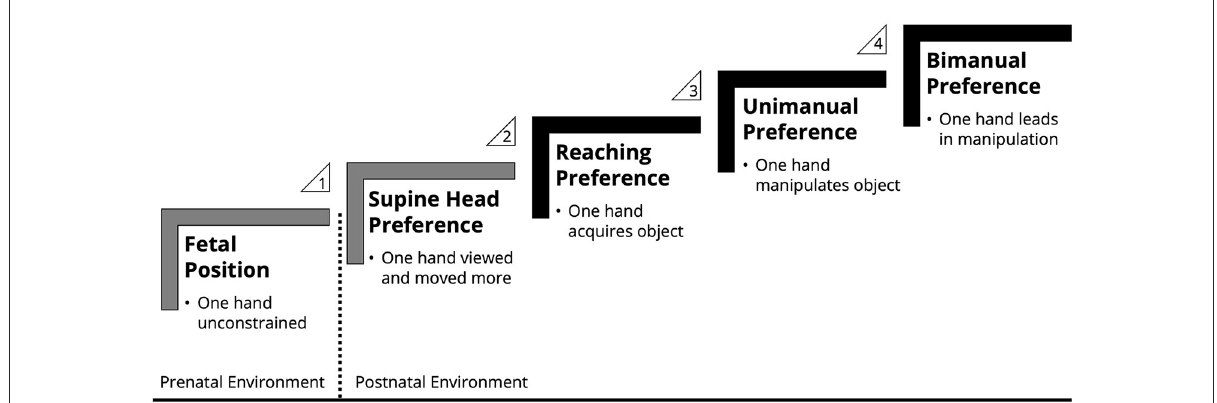
FIGURE1 Handedness emerges in human infants via cascading developmental events. Data supporting the predictive links in the cascade: (1) fetal position predicts head turn preference: Michel and Goodwin (1979); (2) head turn preference predicts reaching hand preference: Michel (1981), Michel and Harkins (1986), Konishi et al. (1987); (3) reaching hand preference predicts unimanual hand preference: Hinojosa et al. (2003), Campbell et al. (2015); (4) unimanual hand preference predicts bimanual hand preference: Babik and Michel (2016). Gray shading denotes postural asymmetries. Black shading denotes manual